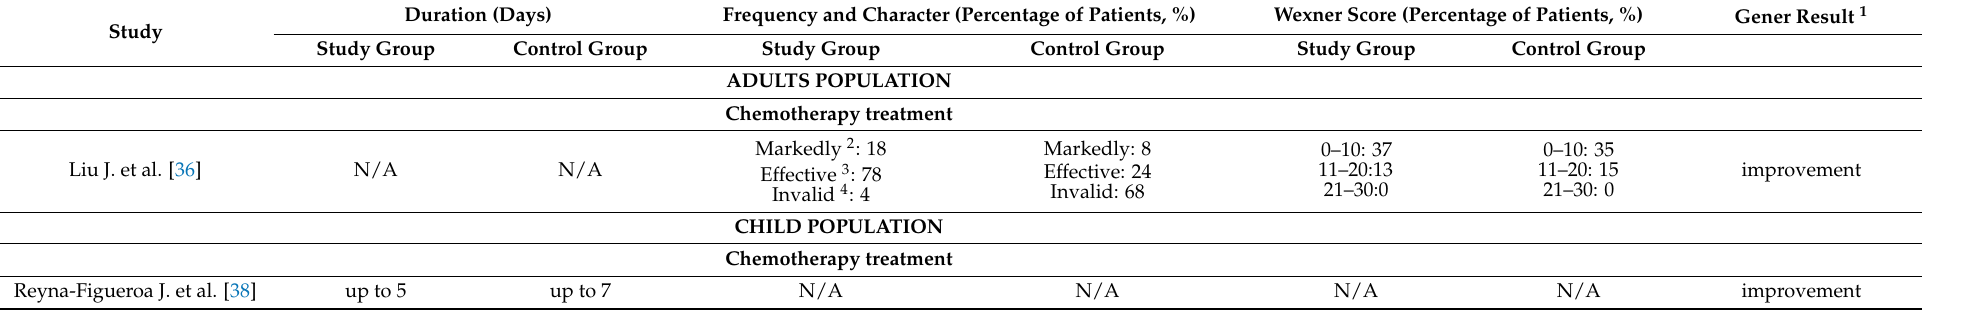
Table 4. The occurrence of constipation during the probiotic treatment.